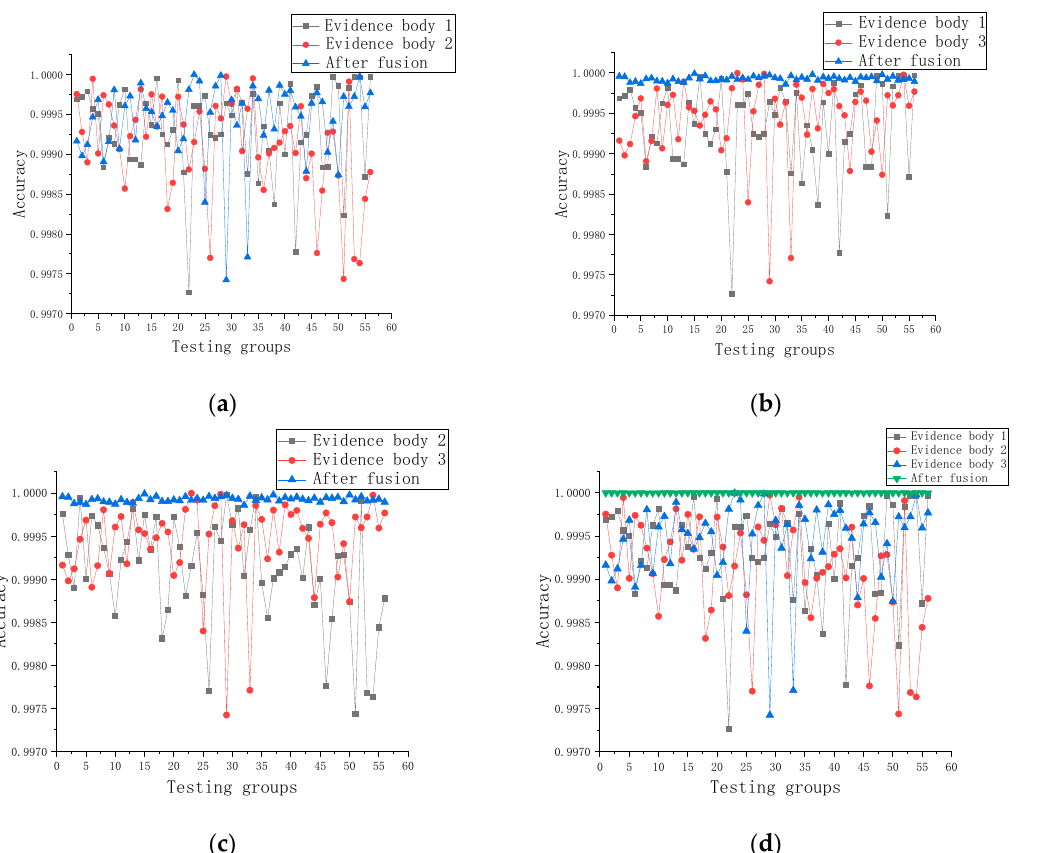
Figure 17. Diagnostic accuracy before and after gear fusion. ( a ) Fusion of evidence body 1 and evidence body 2, ( b ) fusion of evidence body 1 and evidence body 3, ( c ) fusion of evidence body 2 and evidence body 3, ( d ) 3 bodies of evidence fused.